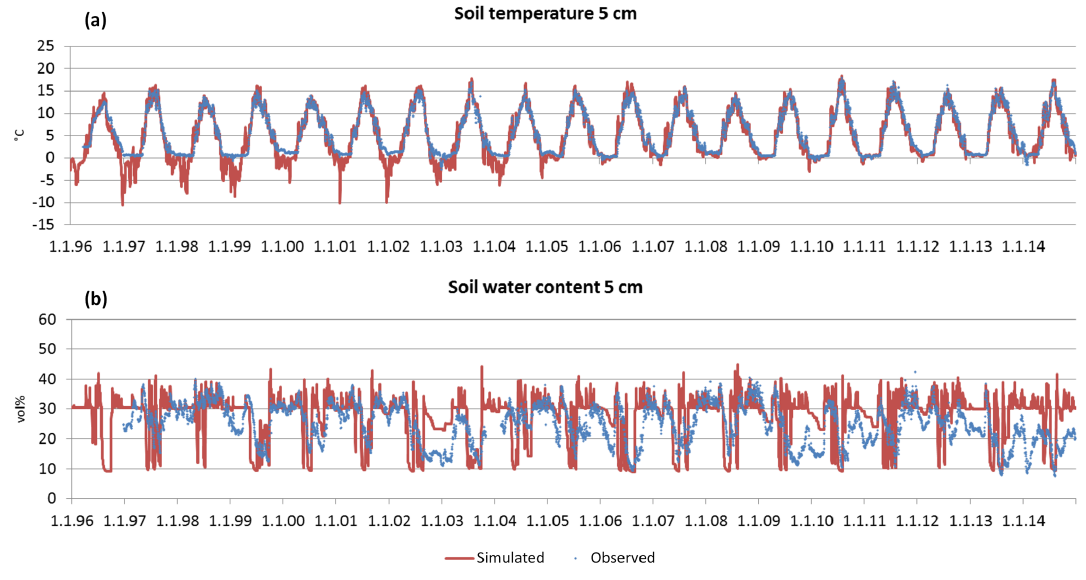
Figure 10. Time series of observed and simulated daily soil temperature (a) and time series of observed and simulated daily soil water content (b) at 5cm of depth in Hyytiälä for the period